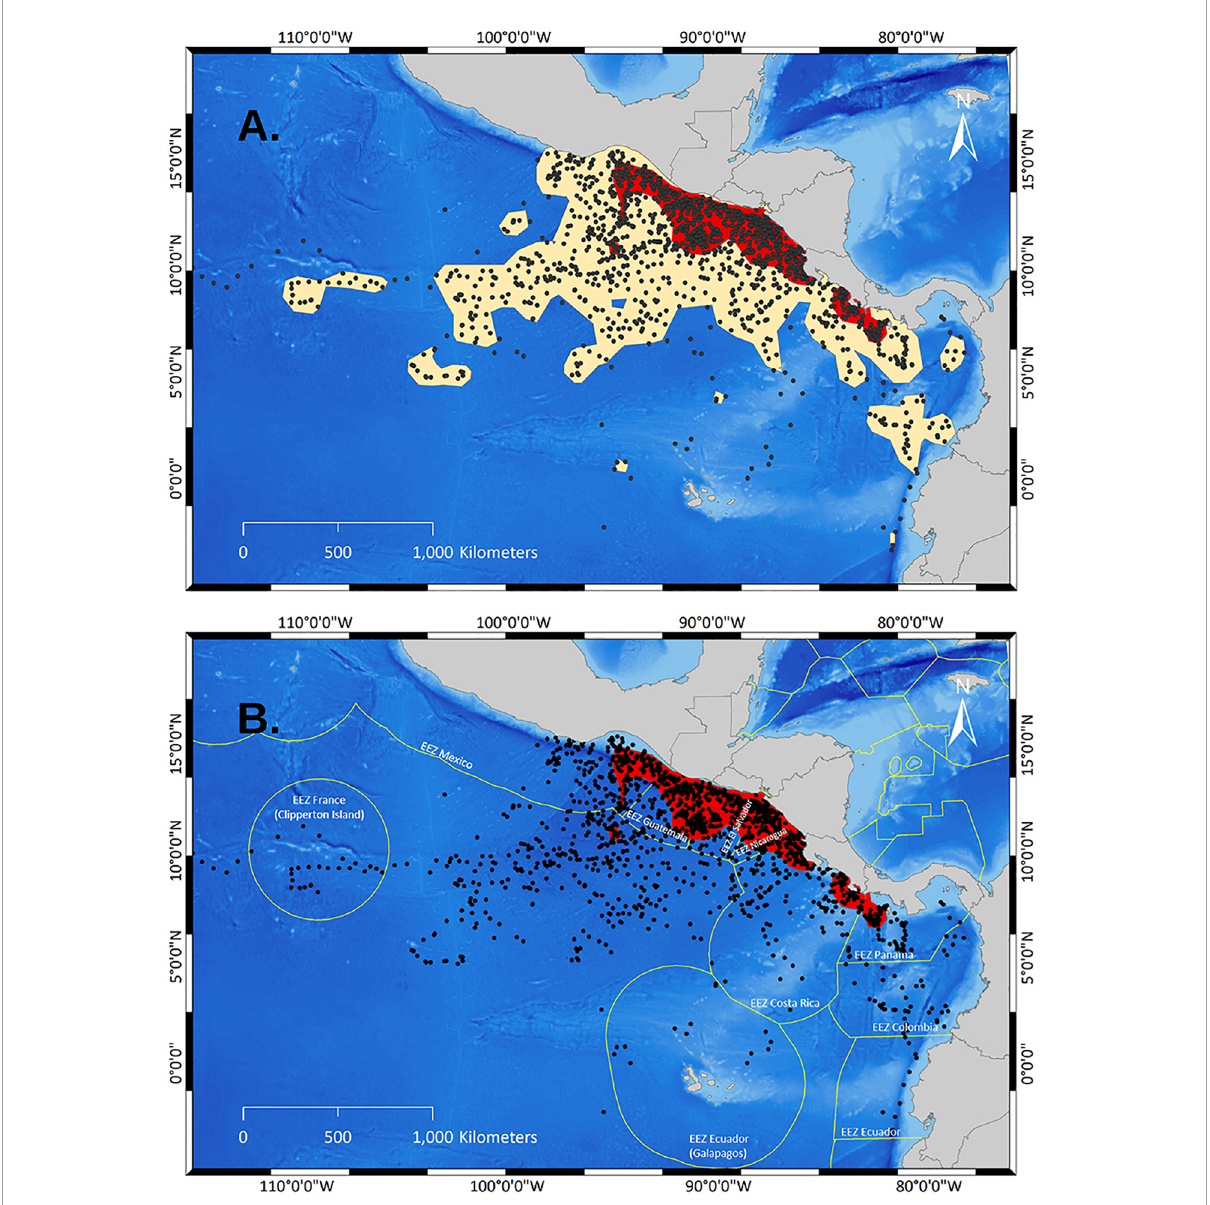
FIGURE2 Utilization Distributions (UD) of olive ridleys within the Eastern Tropical Pacific (ETP) based on KDEs from 43 individual females tracked during their post-nesting migrations from Costa Rican nesting grounds (Data: Plotkin, 2010 and this study). (A) Identified high use areas using locations and a UD in the ETP based on 43 tracks. Red polygons demark PVC 50 (=core areas) and sand colored polygons demark PVC 95 based on KDEs. (B) Locations and core areas of high use overlaid onto the outlines of the Exclusive Economic Zones (Flanders Marine Institute, 2014) within the